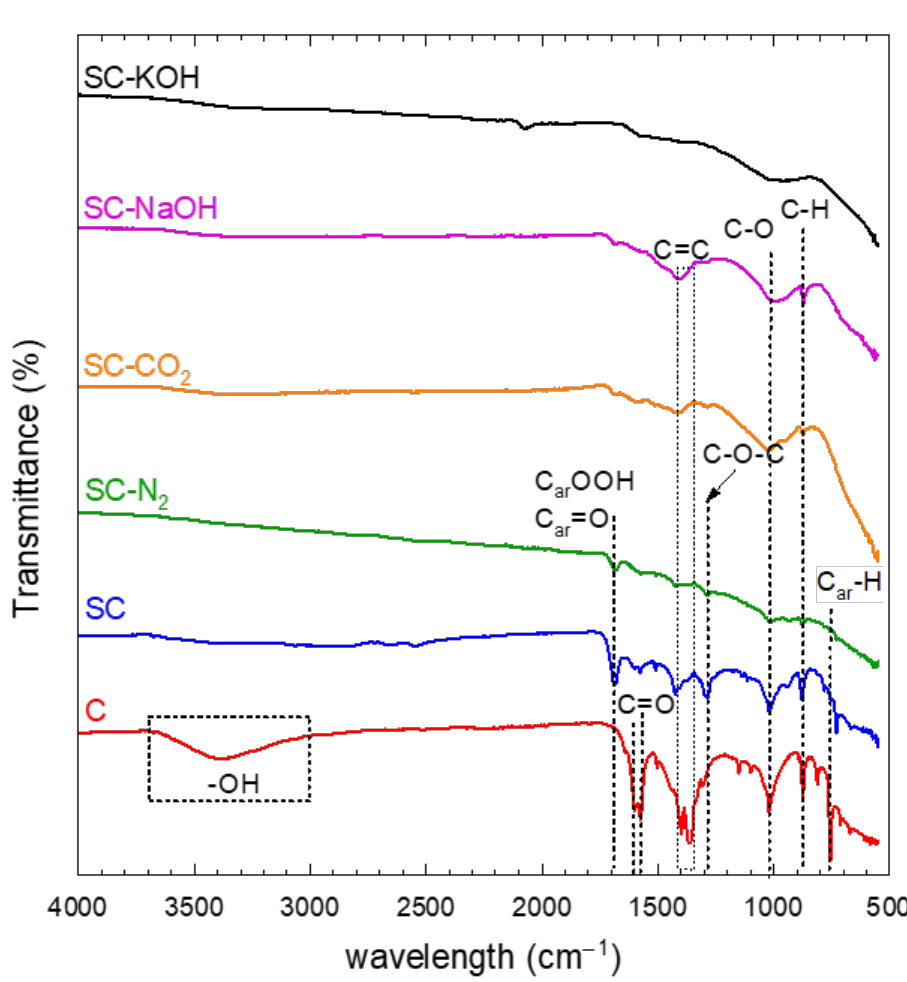
Figure 3. FTIR spectra of the char from plastic pyrolysis before and after activation.